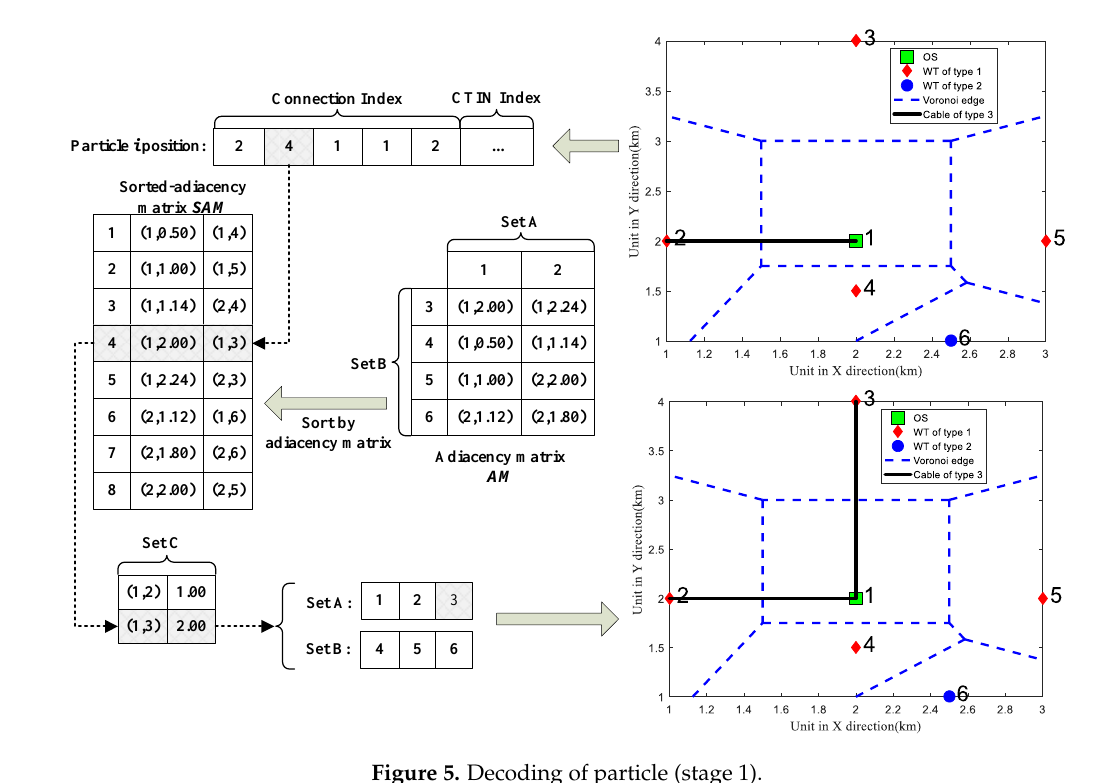
Figure 5. Decoding of particle (stage 1).